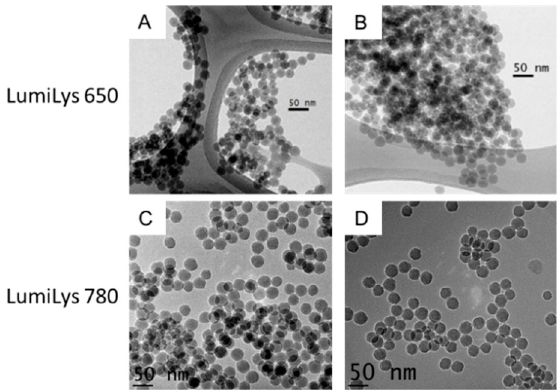
Figure 1. Physical characterization of LumiLys silica nanoparticles (SiNPs). Transmission electron microscopy micrographs of ( A , B ) LumiLys 650 NPs functionalized with Gd-DTPA (Gadolinium-